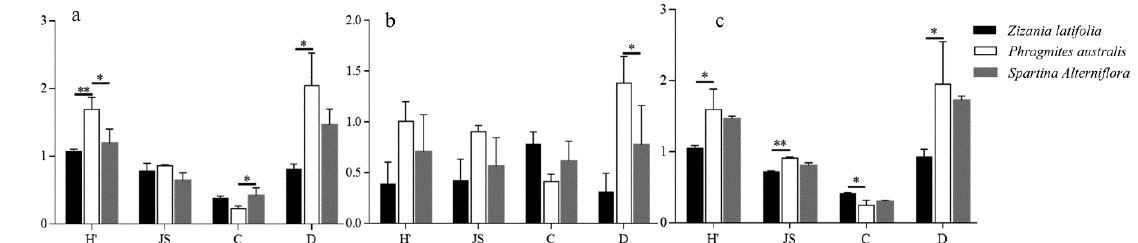
Figure 2. Comparison of the diversity indices of the different vegetation in ( a ) spring, ( b ) summer, and ( c ) autumn. H’ = Shannon–Wiener index, JS = Pielou’s evenness index, C = Simpson dominance index, and D = Margalef abundance index. The values are the means ± SE. * indicates the level of significance. * = significant ( p < 0.05), ** = extremely significant ( p < 0.01).